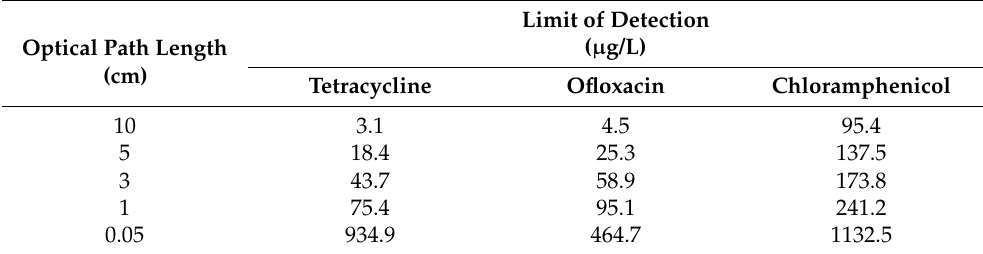
Table 4. LODs of three antibiotics in distilled water at different optical path